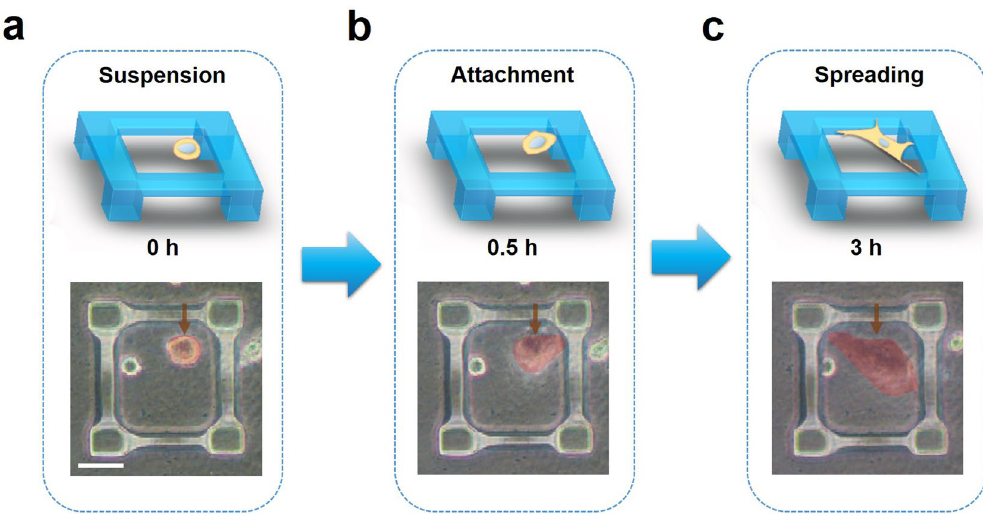
Figure 3. Schematic illustrations and photographed images of a single cell (highlighted in red in the bright field images) adhered to the 3D microscaffolds and its spreading over it. Scale bar = 50 μ